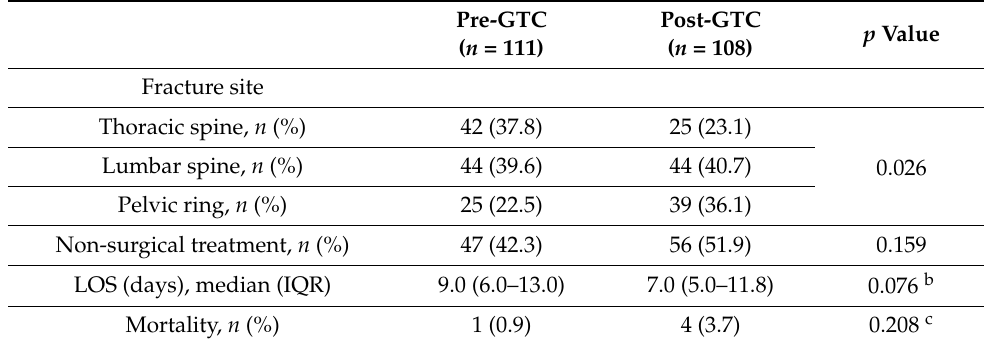
Table 2. In-hospital courses before and after certification as Geriatric Trauma Centre (GTC) a .